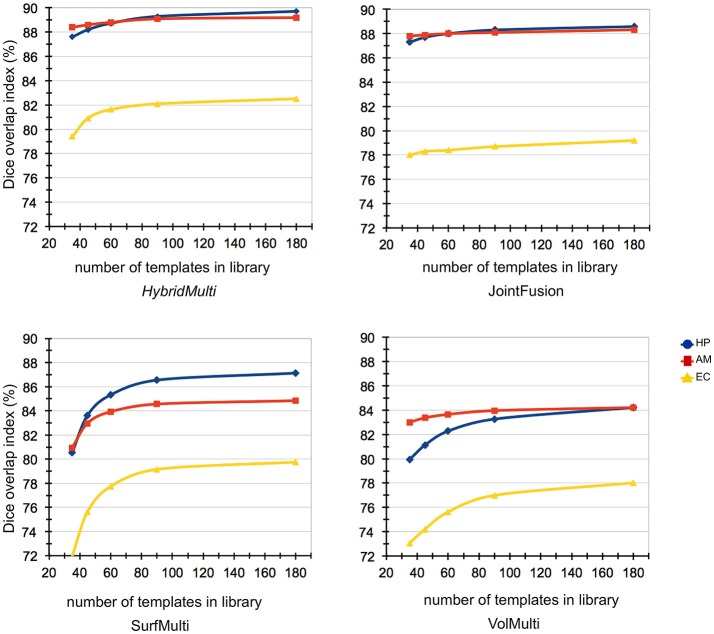
Impact of template library size on automated segmentations. Reducing the template library size from N (n = 175) to N/5 (n = 35) showed that the accuracy of EC segmentation declined fastest compared to HP and AM, consistently in all algorithms tested. Size of the library had a lower influence on segmentation accuracy of HybridMulti, and volume-based approaches (JointFusion, VolMulti) than SurfMulti.